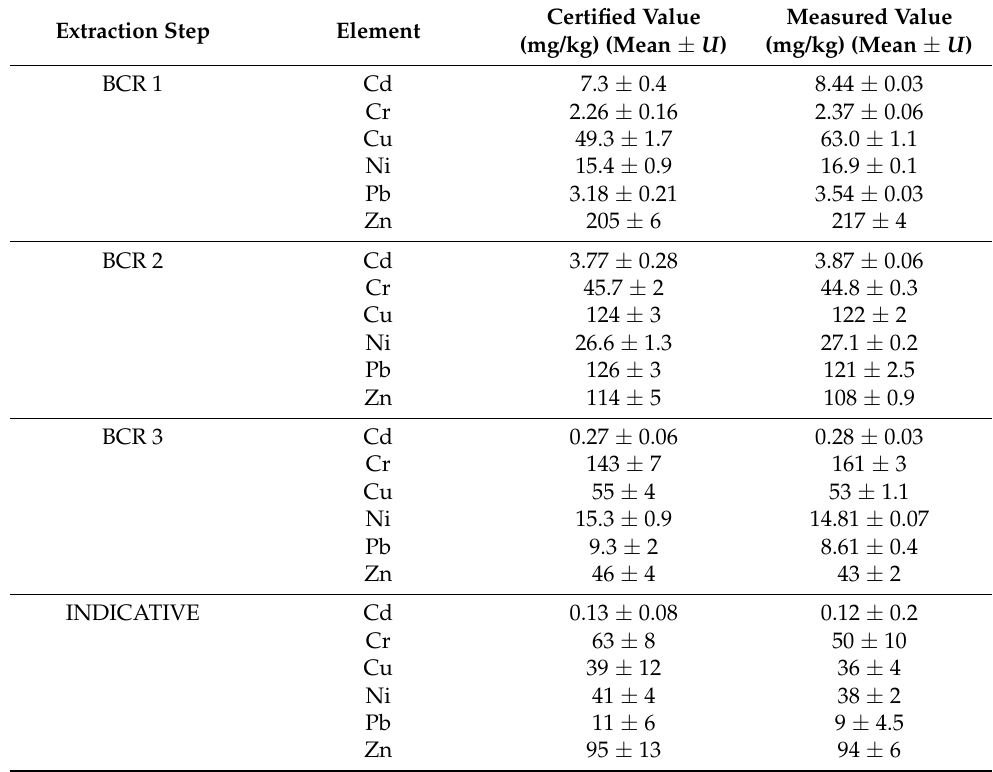
Table 4. Quality control of sequential extraction data using the certified reference material, BCR ® -701. Extraction